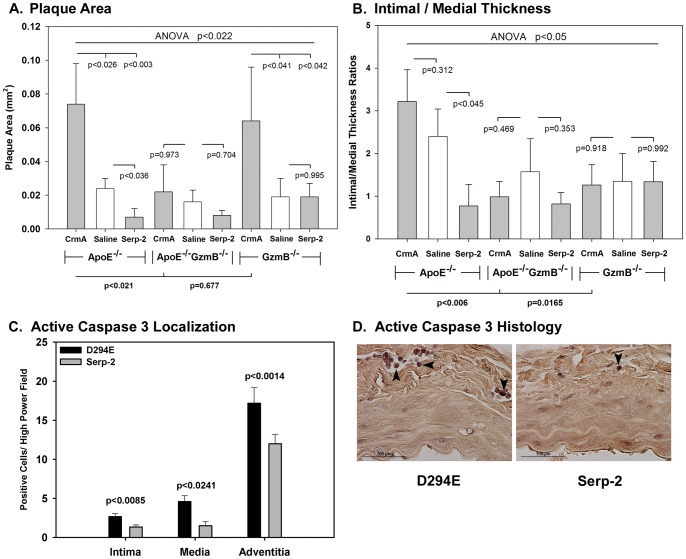
Granzyme B deficiency (GzmB−/−) in donor aorta interferes with Serp-2 inhibition of plaque growth after aortic allograft transplant.ApoE−/− (C57Bl/6) donor aortic allograft transplant into Balb/C recipient mice (N = 16) induced plaque growth at 4weeks follow up as measured by plaque area (A) and intimal to medial thickness (IMT) ratios (B). Serp-2 treatment significantly reduced plaque area (A, p<0.036) and IMT ratios (B, p<0.045) when compared to saline treatment. CrmA treatment markedly increased plaque area (A, p<0.026) and non-significantly increased IMT ratios (B, p = 0.312). Saline treated ApoE−/− GzmB−/− DKO allografts (N = 18) had non-significant reductions in plaque area and IMT when compared to ApoE−/− donor allografts (A, B). CrmA treated ApoE−/− GzmB−/− DKO allografts had significantly reduced plaque area (A, p<0.021) and IMT (B, p<0.006) when compared to CrmA treated ApoE−/− donor allografts. Serp-2 no longer reduced plaque area (A) or IMT (B) in either GzmB−/− allografts (p = 0.995 for plaque area and p = 0.992 for IMT) or ApoE−/− GzmB−/− DKO (p = 0.704 for plaque area and p = 0.353 for IMT). Serp-2 but not Serp-2 mutant D294E significantly reduced caspase 3 staining in all three arterial layers (Fig6C, p<0.024) in PAI-1−/− mice 4weeks post-aortic transplant. Immunostained sections for caspase 3 illustrate reduced staining in mononuclear cells in Serp-2 treated PAI-1−/− aortic transplants when compared toD294E treatment (Fig6D, Mag 400X).